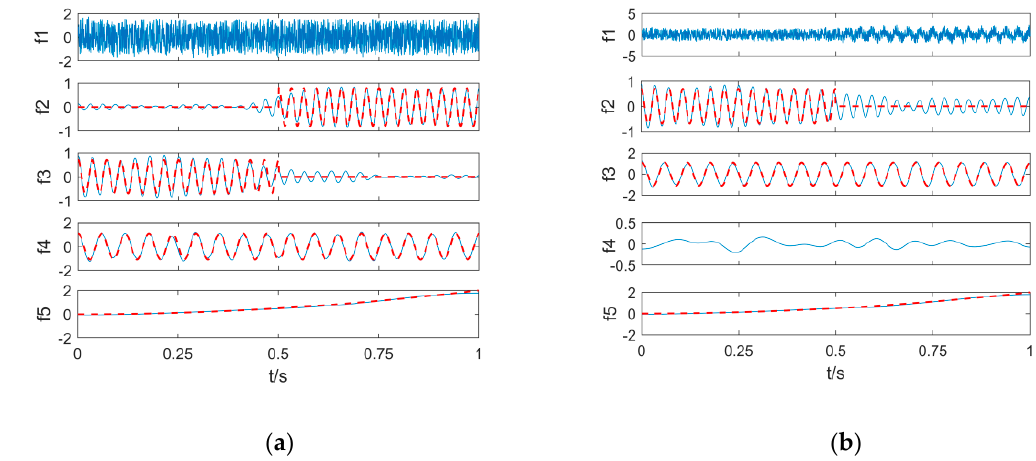
Figure 3. The improved EWT and traditional EWT decomposition results (red dotted lines represent the original signal; blue solid lines represent the decomposition results). ( a ) Improved EWT; ( b )